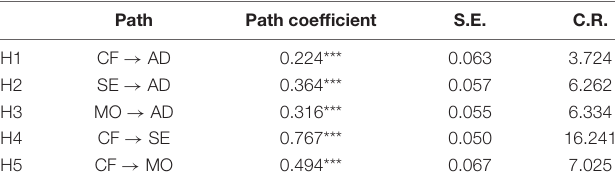
TABLE 6 | Results of structural model testing.